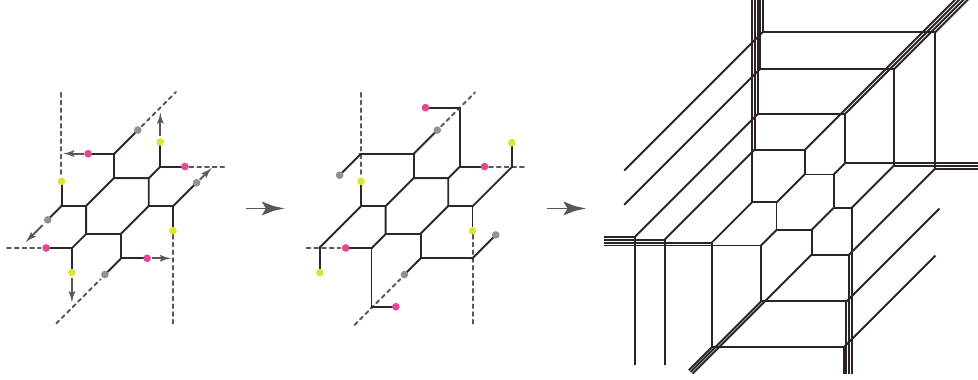
Figure 53 . An example of Tao diagram for 5d SU(2) theory of N f = 8. There are twelve 7-branes of various charges which are the end point of 5-branes of the same charge. The colored dots denote 7-branes and di(cid:11)erent colors means di(cid:11)erent charges. Middle: six branch cuts are chosen such that other remaining 7-branes are supposed to cross as being pulled to in(cid:12)nity. Right: the charges of 7-branes are altered as they crossed the branch cut. A repeated process generates an in(cid:12)nite spiral web. Right: the last step is to pull out 7-branes associated with the branch cuts. In so doing, the Hanany-Witten transition creates 5-branes along the direction that the 7-branes are pulled out such that the newly created 5-branes are bound by one 7-brane. The resulting diagram makes a Tao diagram which possesses a constant period giving rise to KK mode, and in(cid:12)nite web diagram corresponding to in(cid:12)nite KK spectrum so that the Tao diagram describes a circle compacti(cid:12)cation of 6d